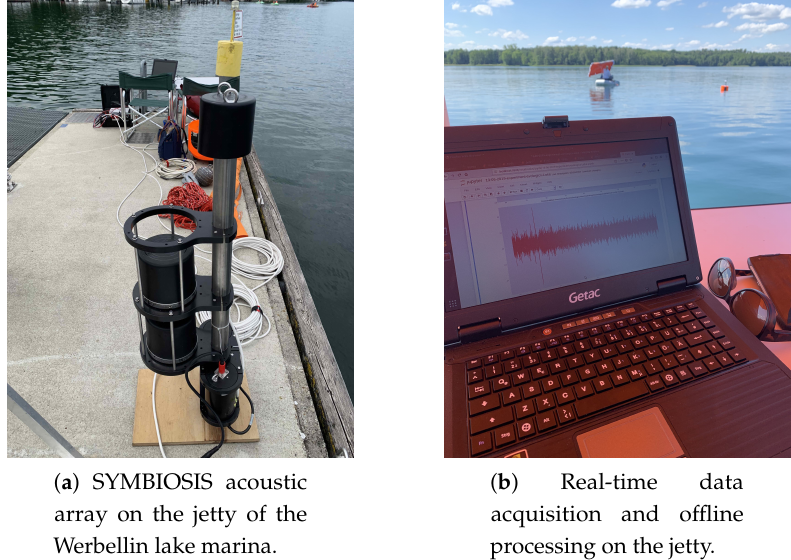
Figure 8. Photos of the deployment: ( a ) acoustic array of the SYMBIOSIS platform on the jetty, before deployment; ( b ) ongoing experiment, showing a snapshot of a captured signal on the laptop’s